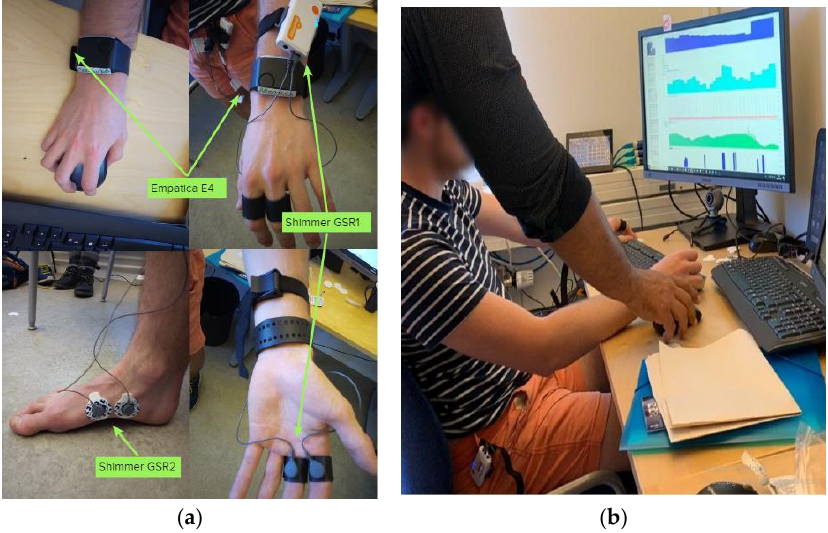
Figure 2. Placing the GSR sensors on a subject from the test group ( a ); checking the streaming data in iMotion software ( b ). iMotion software ( b